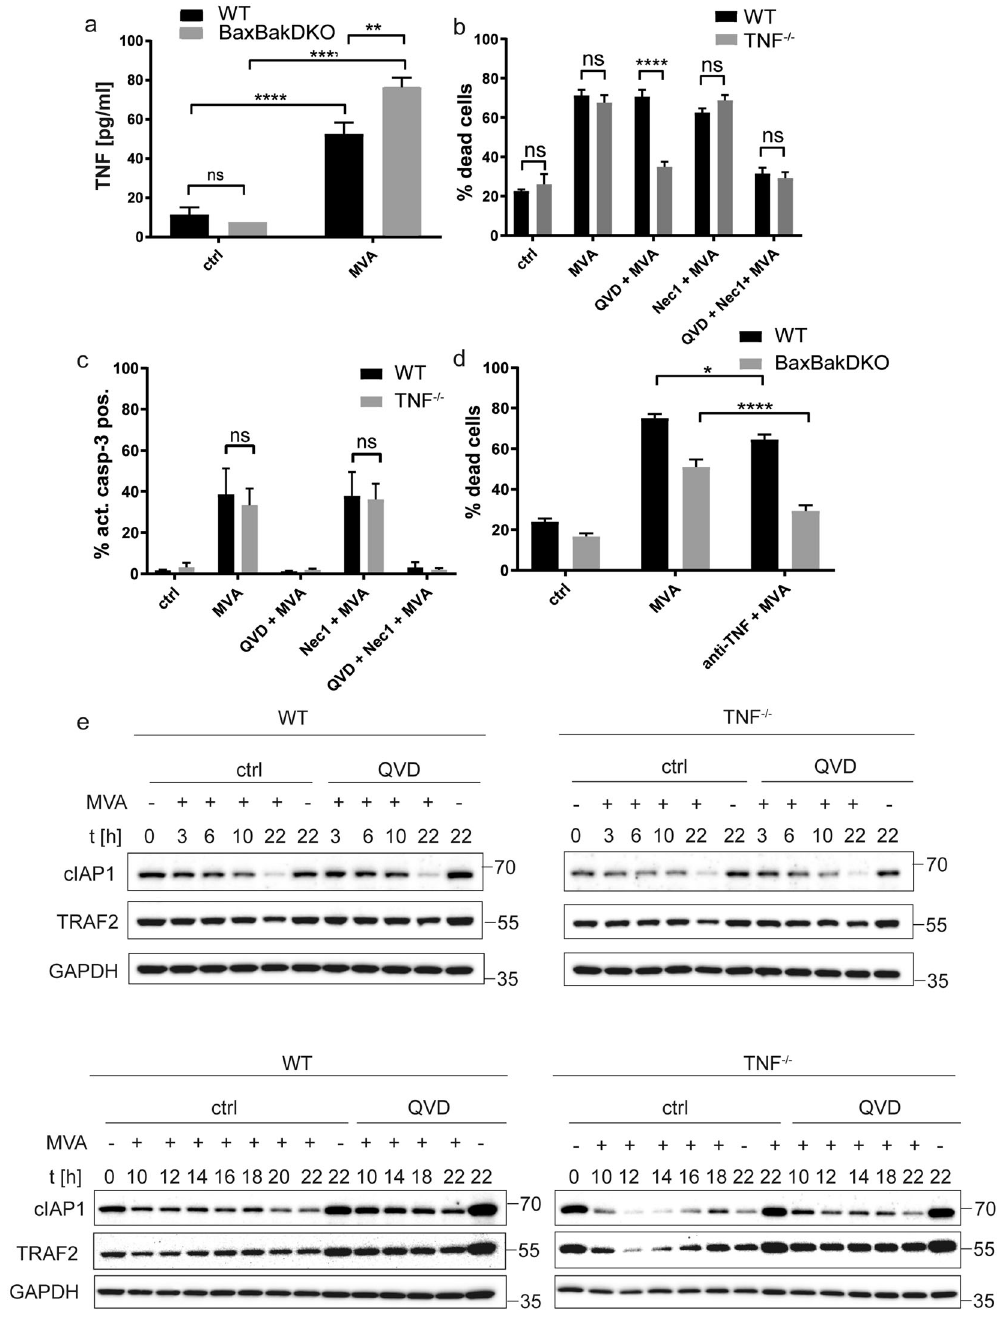
Fig. 3 Involvement of TNF-signaling in MVA-induced macrophage cell death. a , b D7 differentiated wt (black bars) or Bax/Bak-DKO (gray bars) Hoxb8 macrophages were infected with MVA at a MOI of 2 and harvested after 22 h by accutase treatment followed by annexin/PI staining ( a ) or active caspase-3 staining ( b ) and fl ow cytometry analysis. Inhibitors were used at the following concentrations where indicated: QVD, 20 µM; Nec-1, 10 µM. c Supernatants of d7 differentiated wt (black bars) or Bax/Bak-DKO (gray bars) Hoxb8 macrophages infected with MVA at an MOI of 2 for 22 h were analysed for secreted TNF by ELISA. d D7 differentiated wt (black bars) or Bax/Bak-DKO (gray bars) Hoxb8 macrophages were infected with MVA at a MOI of 2 and harvested at the indicated time points by accutase treatment. Where indicated, samples were concomitantly treated with anti-TNF antibody (1:1000). Cells were analysed for cell death by annexin V/PI staining followed by fl ow cytometry. The rate of dead cells was determined as a percentage of annexin/PI-positive cells (cells positive for annexin V or PI or both). e D7 differentiated wt or TNF − / − Hoxb8 macrophages were infected with MVA at an MOI of 2 and harvested at the indicated time points by accutase treatment. Cells were lysed in Laemmli sample buffer and samples were boiled at 95 °C for 5 min. Samples were subjected to SDS- PAGE on 4 – 20% TRIS-glycine gels, transferred onto nitrocellulose membranes, and probed with the antibodies indicated. The pan-caspase inhibitor QVD was used at a concentration of 20 µM where indicated. GAPDH served as a loading control. Blots are representative of at least two independent experiments. Shown are means/SEM of n = 4 ( a , b , d ) or n = 6 ( c ) independent experiments. * p < 0.05; ** p < 0.01; *** p < 0.001; **** p < 0.0001; ns nonsigni fi cant ( p ≥